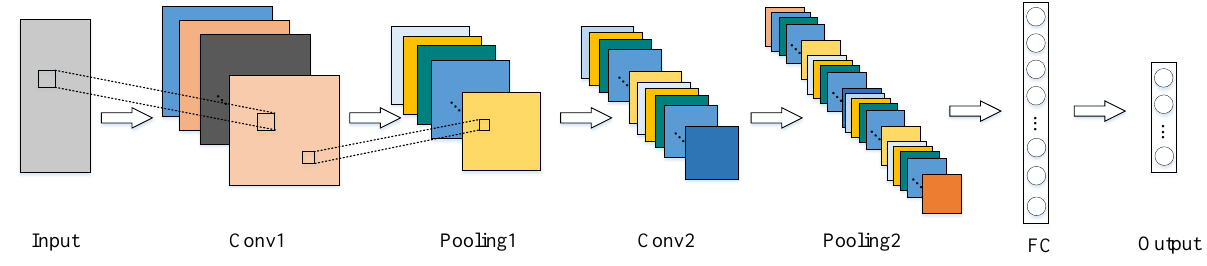
Figure 2. The main structure of the CNN. Conv1 and Conv2 represent Convolutional Layers 1 and 2. Pooling1 and Pooling2 stand for Pooling Layers 1 and